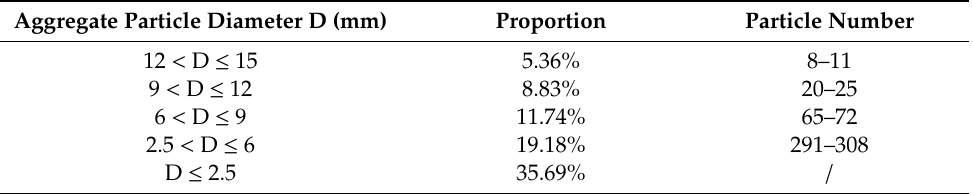
Table 1. Aggregate gradation and particle number.